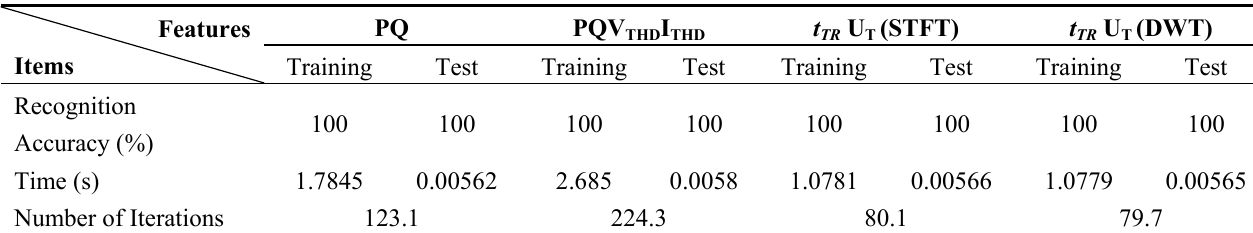
Table 1. The results of load identification in Case Study